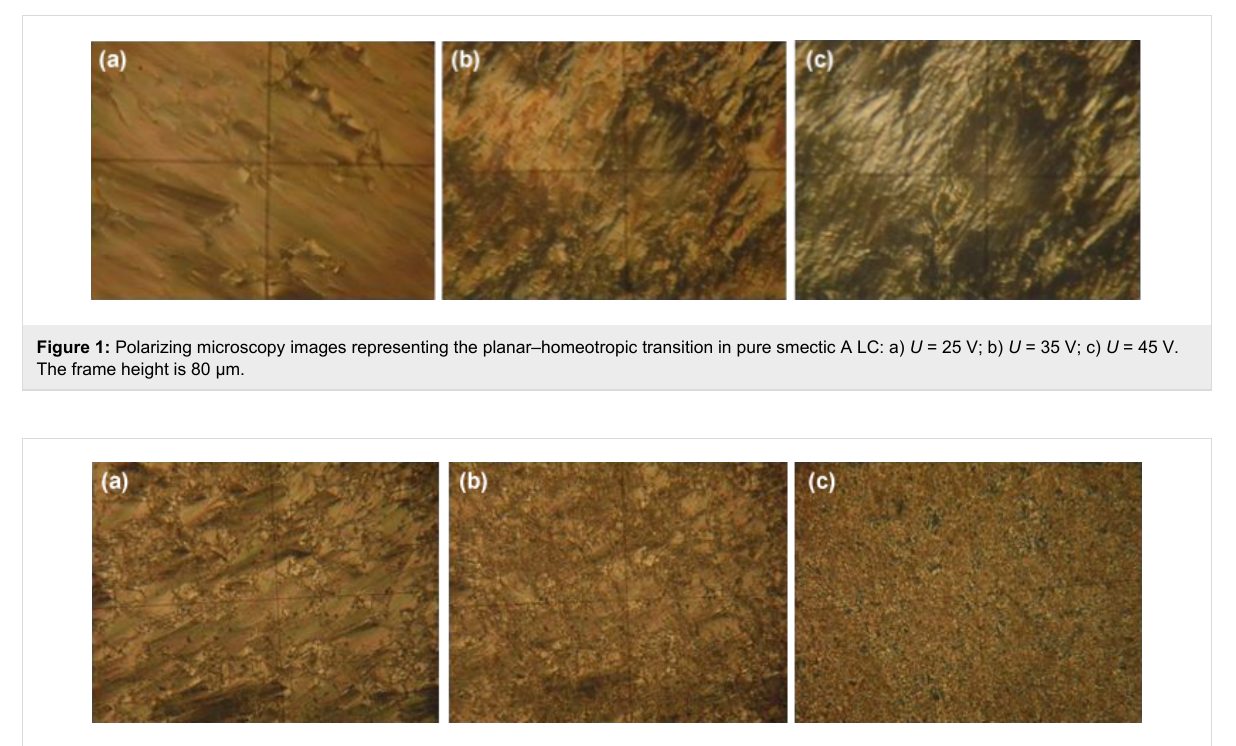
Figure 2: Polarizing microscopy images representing the planar–homeotropic transition in a colloid of smectic A LC + BaTiO 3 : a) U = 15 V; b) U = 20 V; c) U = 25 V. The frame height is 80 μ m.